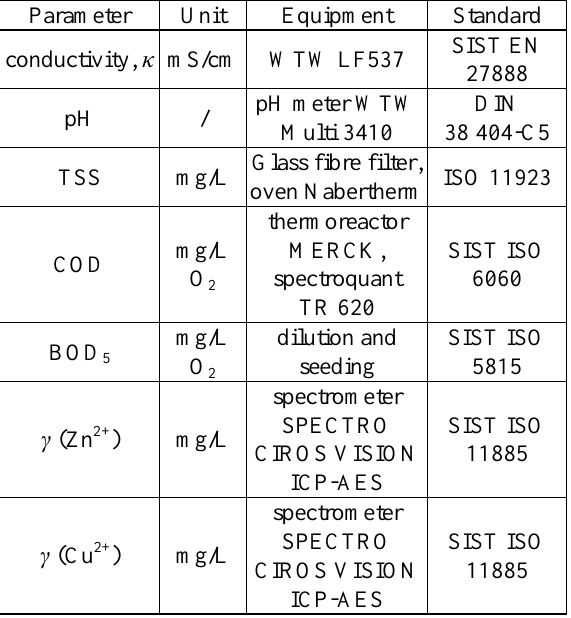
Table 2. Measured parameters, equipment and standard for determination physicochemical parameters Parameter Equipment